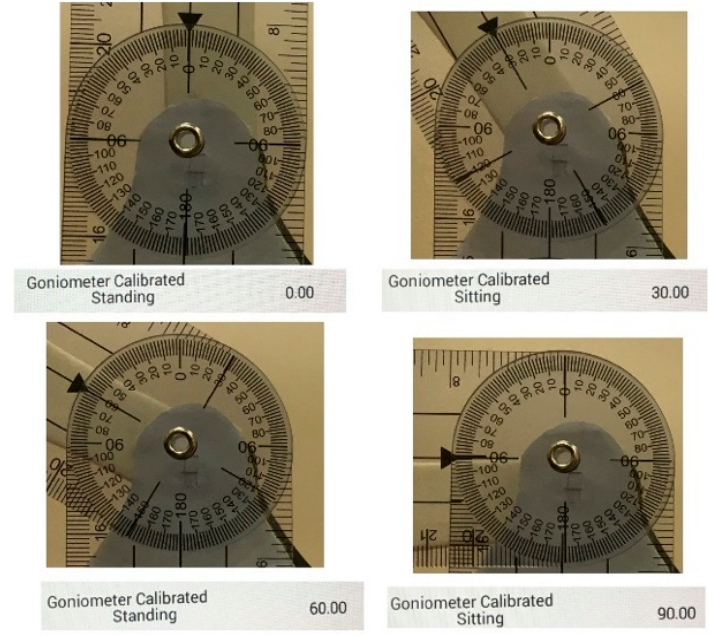
Figure 8. Results of the comparison between wearable and commercial goniometer. Table 1. Average of the MAE during the comparison of the differences calculated by the wearable and the Aktos-t system during the activity of walking. The results are shown in the format mean ± standard deviation.